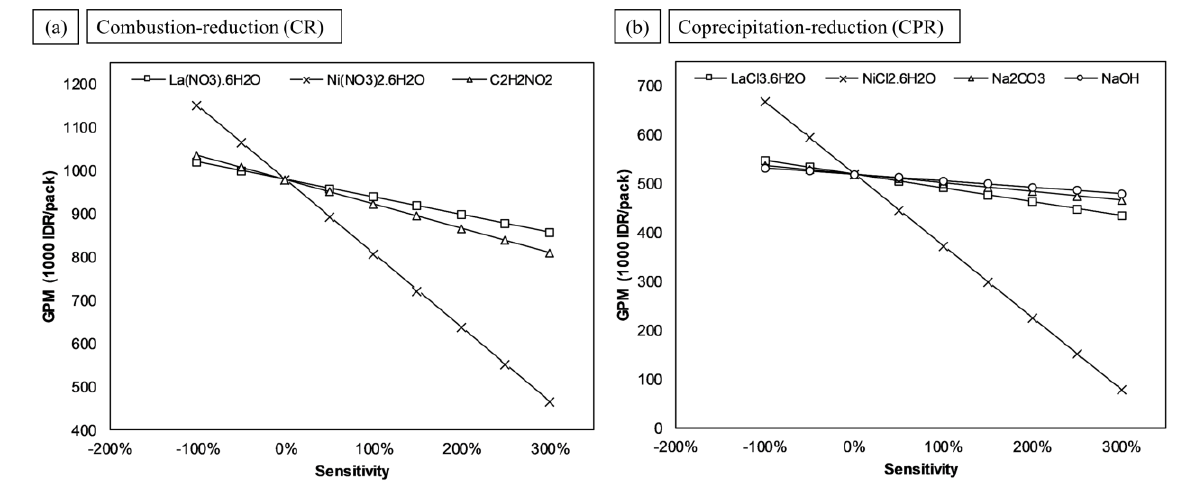
Fig. 3. Effect of changing raw materials (reagents) to the GPM for (a) combustion-reduction (CR) and (b) coprecipitation-reduction